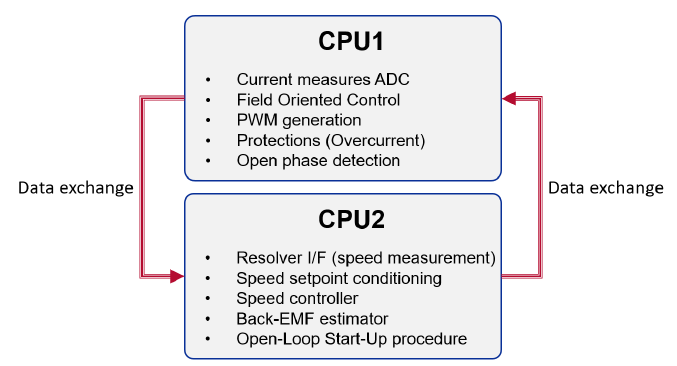
Figure 3. Control implementation on the processors.